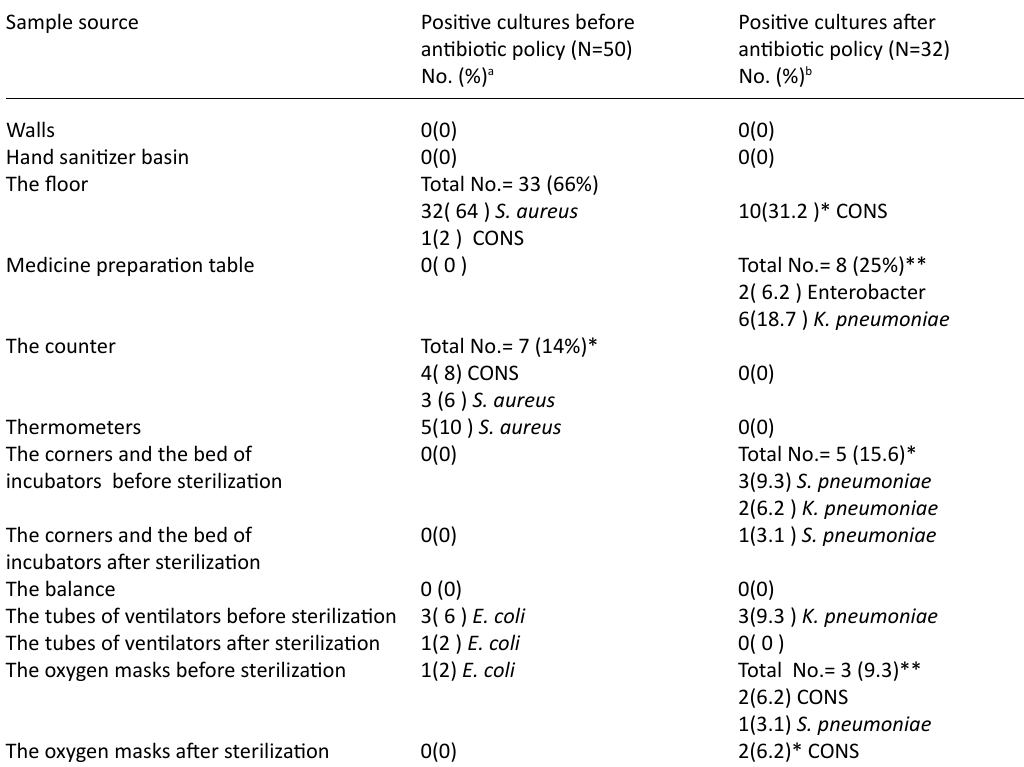
Table 2. Distribution of the isolated environmental pathogens according to the source of the samples. Sample